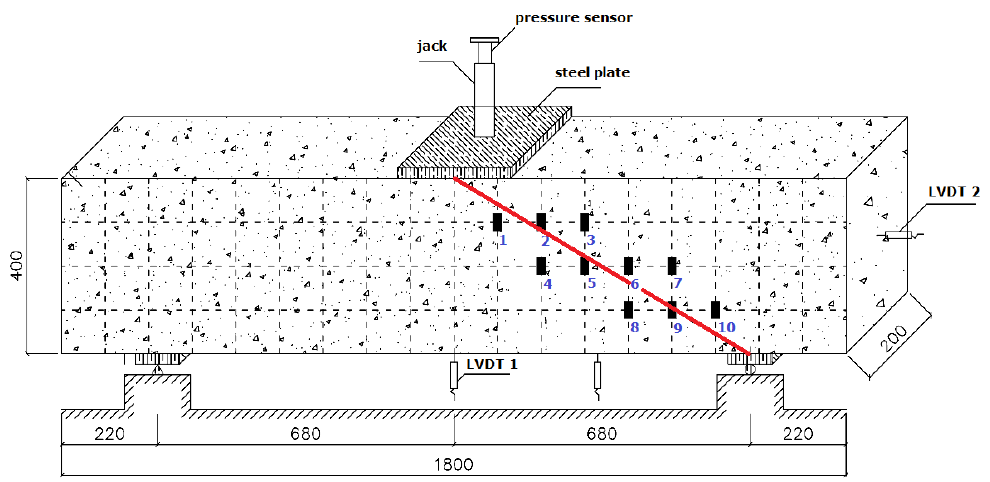
Figure 9. Strain gauges on the RC-control beam (unit: mm).